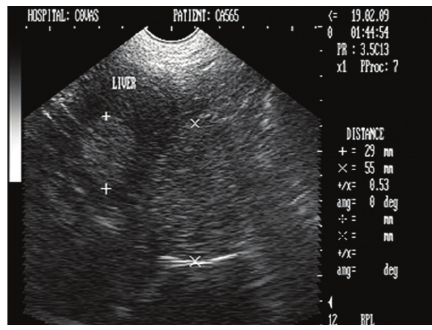
Figure 32: Two-dimensional ultrasonographic transverse scan in a five-year-old intact mixed-breed dog showing an encapsulated hypoechoic hepatic mass with irregular